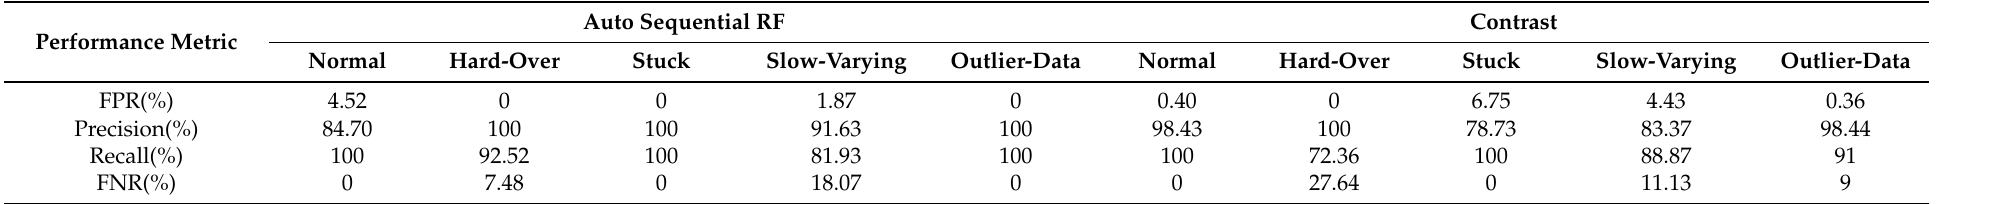
Table 4. Real-time fault diagnosis result.